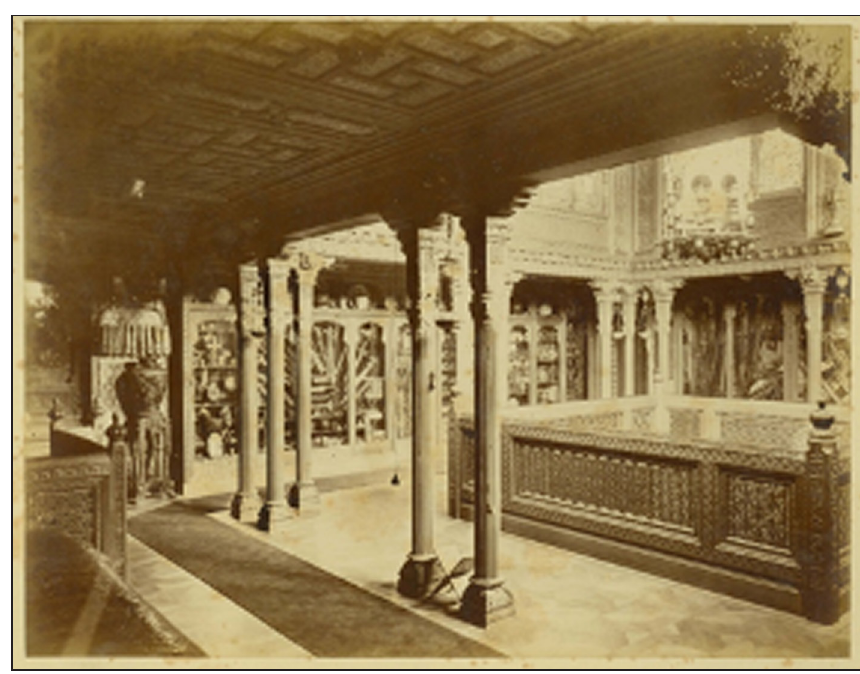
Fig. 3 : Photograph of the Durbar Hall in Hastings Museum (donated by the Bras- sey family in 1919). © Hastings Museum and Art